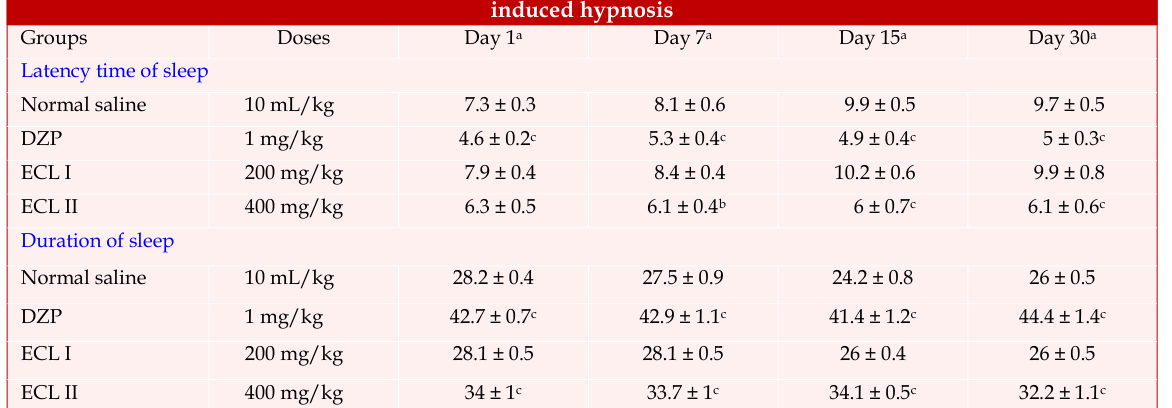
Effect of Cocculus laurifolius extract on latency time and duration of sleep in